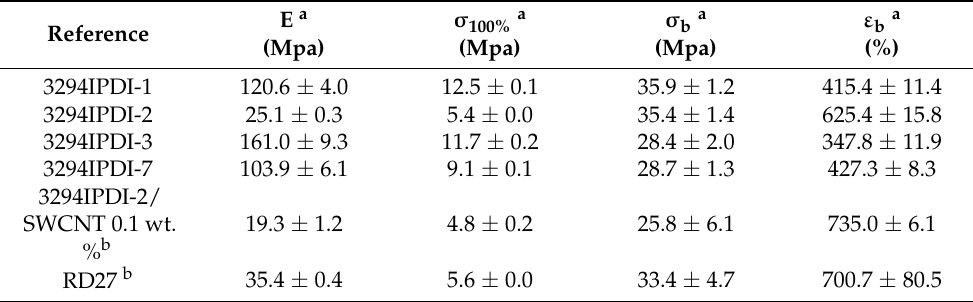
Table 6. Mechanical characterization of WPUD and RD27 films.